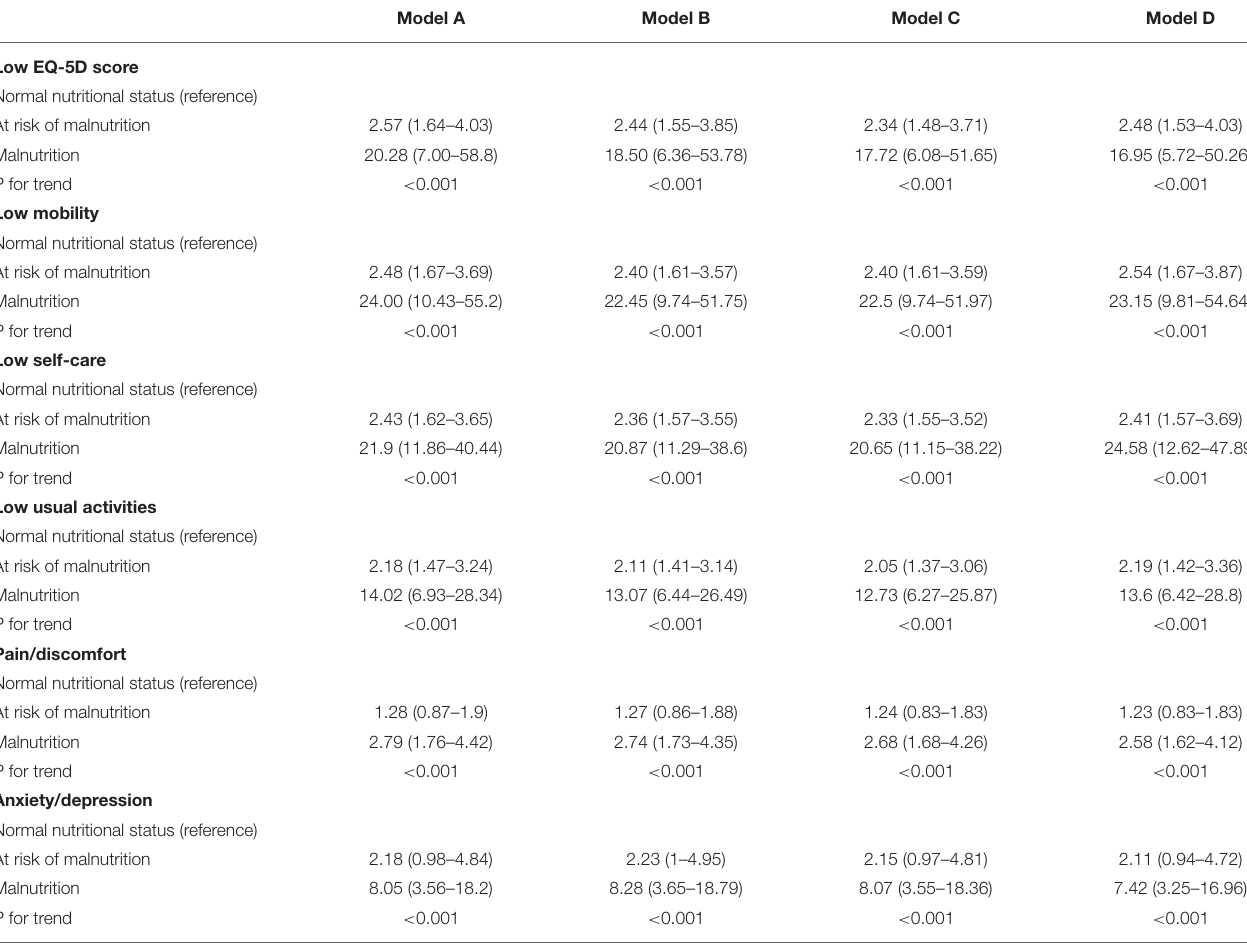
TABLE 4 | The odds ratios (95%CI) of nutritional status on low EQ-5D score and its sub-domains among